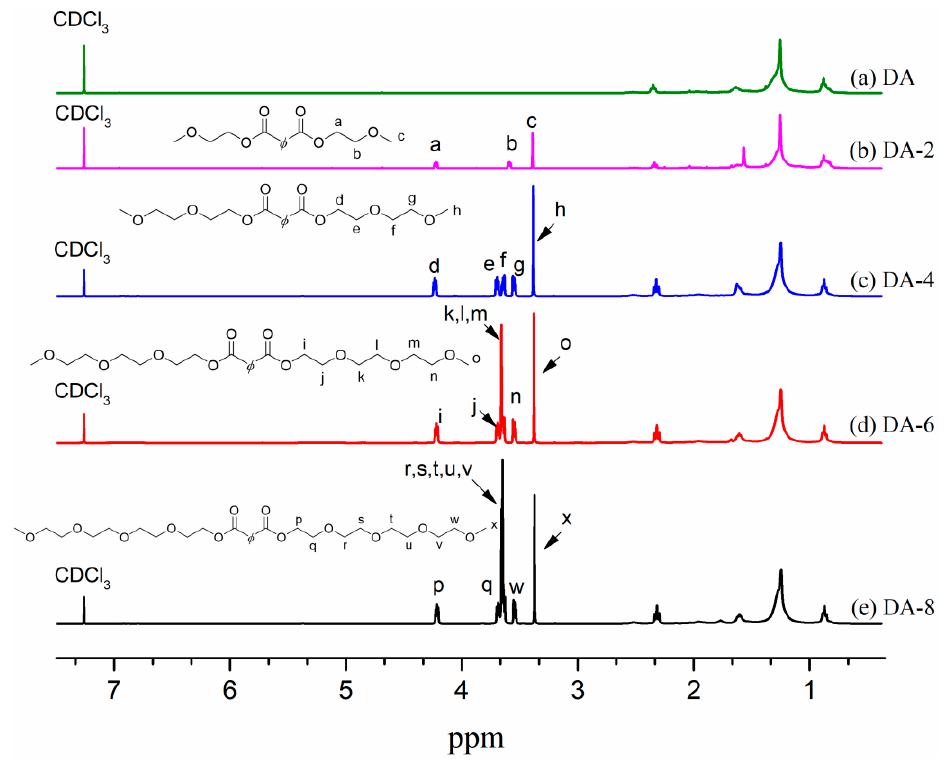
Figure 1. 1 H NMR spectra of ( a ) DA, ( b ) DA-2, ( c ) DA-4, ( d ) DA-6, and ( e ) DA-8. Note: ø represents residues of DA, except for carboxylate.